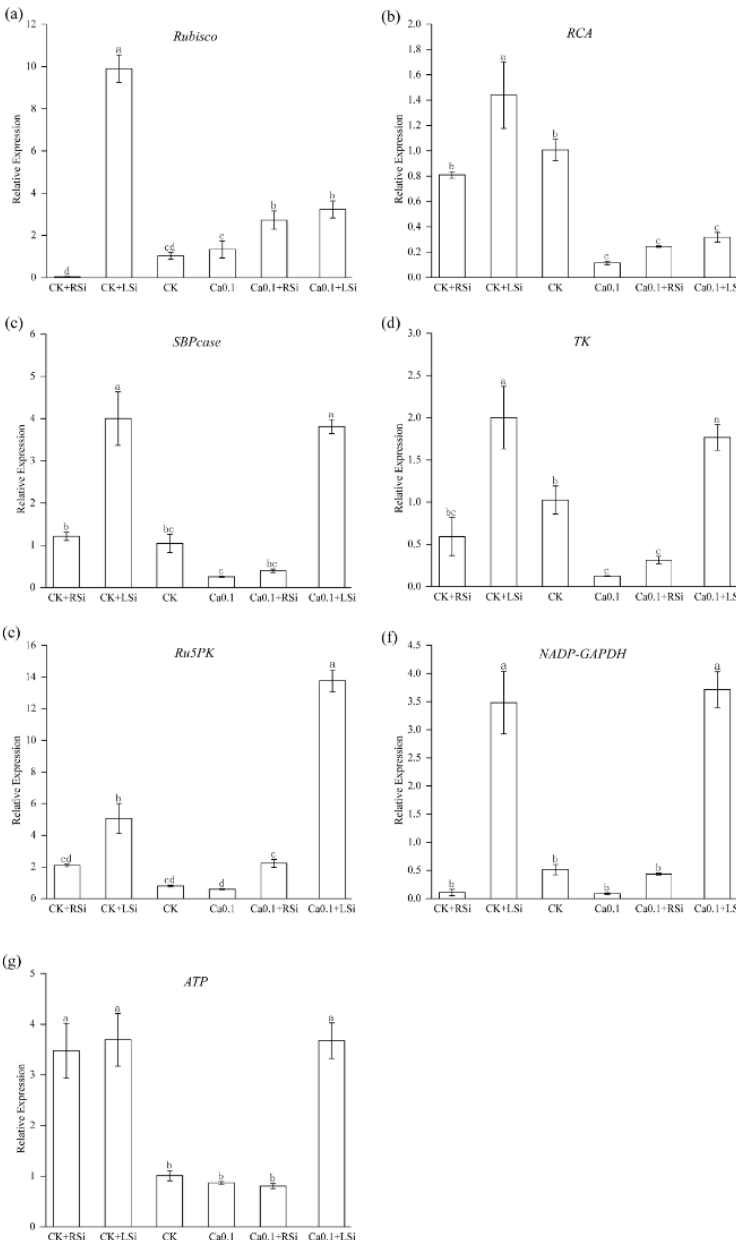
Figure 8. Effect of exogenous Si on the expression of photosynthetic related genes in tomato under low calcium stress. ( a ) Rubisco : rubisco coenzyme; ( b ) RCA : ribulose diphosphate carboxylase/oxygenase activating enzyme or rubisco activating enzyme; ( c ) SBPcase : 1,7 − diphosphoglycosylase; ( d ) TK : transketolase; ( e ) Ru5PK : ribulose 5 − phosphate kinase; ( f ) NADP − GAPDH : 3 − phosphoglycerate dehydrogenase; ( g ) ATP : ATP synthase subunit. The means of three replicates ± standard error is shown. The data were subjected to an ANOVA test to determine the LSD, and bars superscribed by different letters are significantly different at p < 0.05. Standard errors are indicated by bars. CK + RSi: 4 mM Ca in Hoagland nutrient solution + root application of 1 mM Si; CK + LSi: 4 mM Ca in Hoagland nutrient solution + foliar application of 1 mM Si; CK: 4 mM Ca in Hoagland nutrient solution; 0.1Ca: 0.1 mM Ca in Hoagland nutrient solution; 0.1Ca + RSi: 0.1 mM Ca in Hoagland nutrient solution + root application of 1 mM Si; 0.1Ca + LSi: 0.1 mM Ca in Hoagland nutrient solution + foliar application of 1 mM